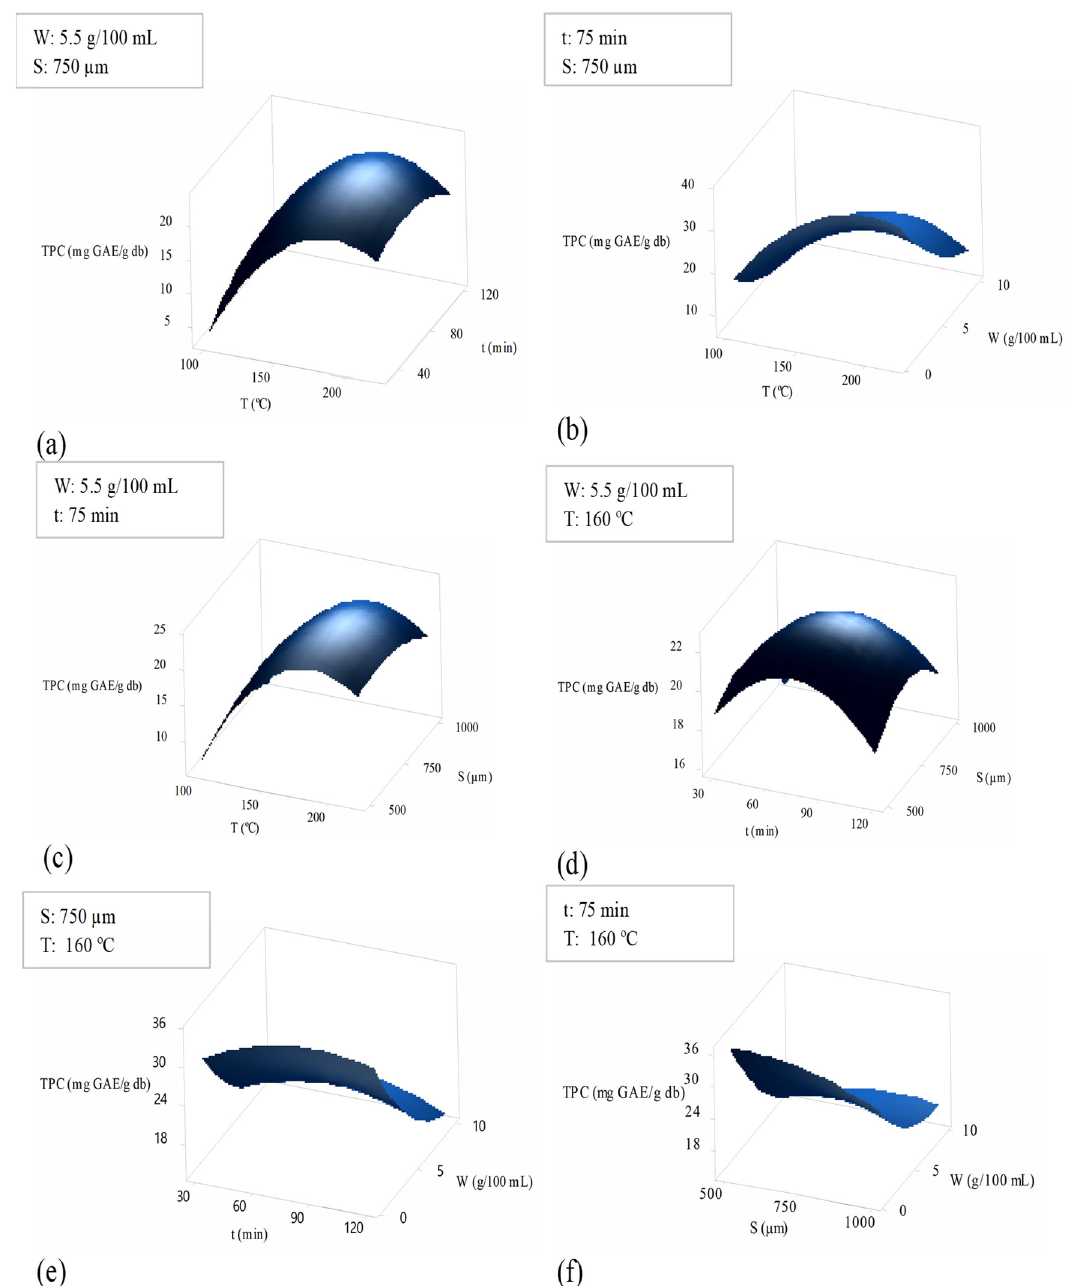
Figure 2. Interaction effects of the subcritical water extraction parameters on total polyphenolic compound (TPC) content represented by response surface plots. The values of the process parameters kept constant are highlighted in legends. T = temperature, t = time, W = solid-to-solvent ratio, S = mean sample particle size.